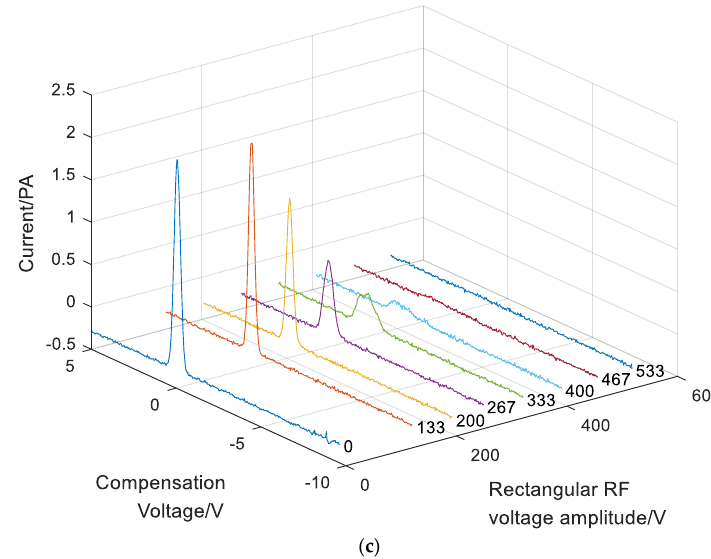
Figure 10. High-field asymmetric ion mobility spectrometry (FAIMS) spectra for acetone, ethanol and acetic ether with different applied radio frequency (RF) voltages. ( a ) Acetone; ( b ) Ethanol; ( c ) Acetic ether.